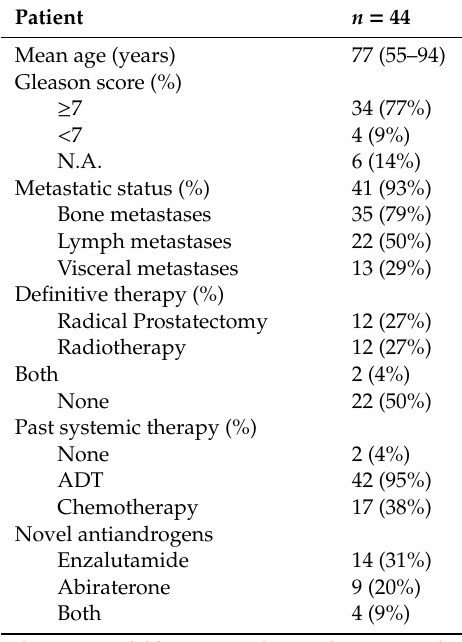
Table 1. Patient